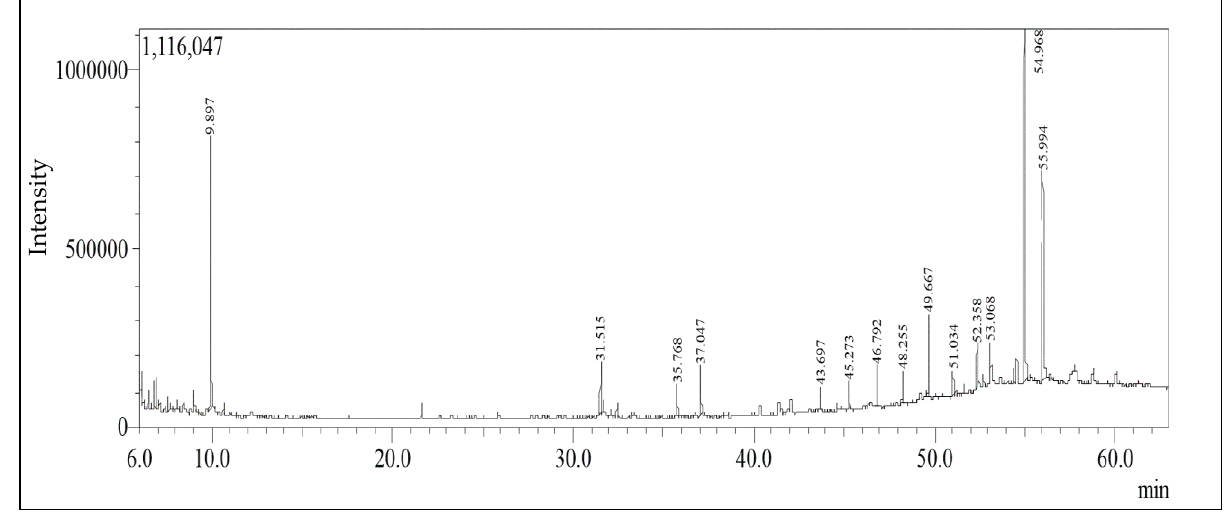
Figure 1. GC/MS chromatogram (TIC) of Annona glabra hexane extract.